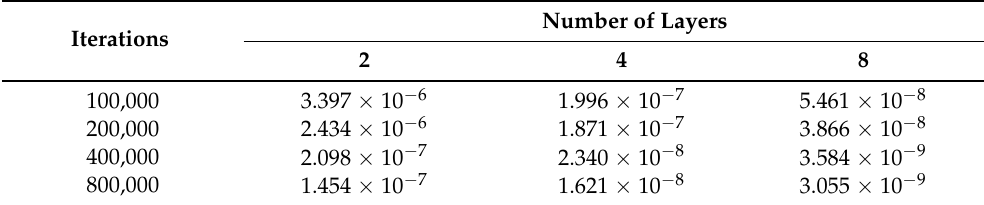
Table 1. Results of the mean square error analyzing of varying number of iterations and number of layers in the simulations.